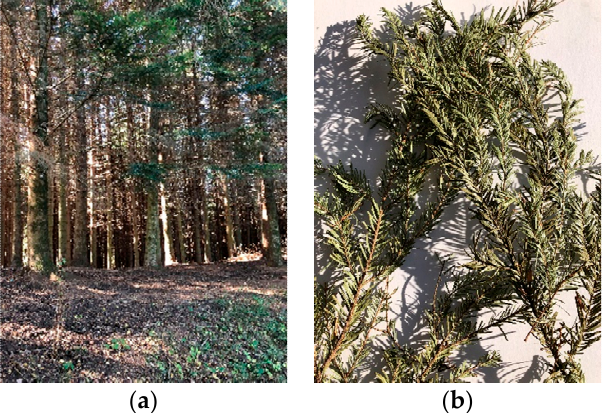
Figure 2. ( a ) View of a portion of the mixed firs forest; ( b ) silver fir twigs and needles.